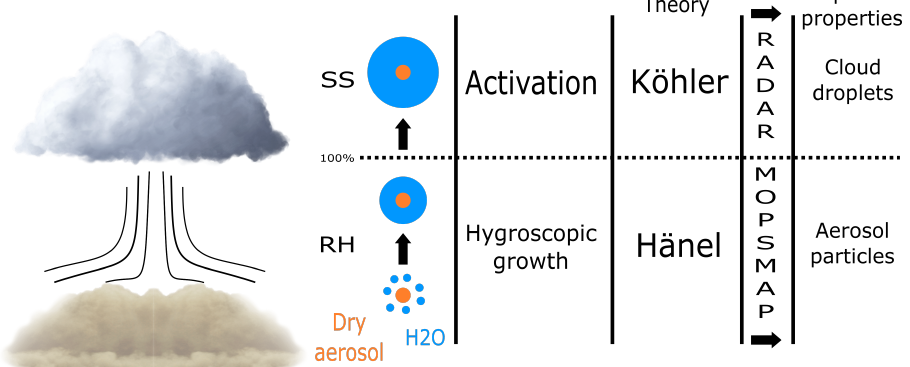
Figure 1. Simulation scheme (left to right columns): the ascent of the dry air parcel, cloud formation, atmospheric process and theories, retrieval of aerosol and cloud optical properties from the PSD and DSD, respectively; and generation of lidar (aerosol and cloud) and radar (cloud)